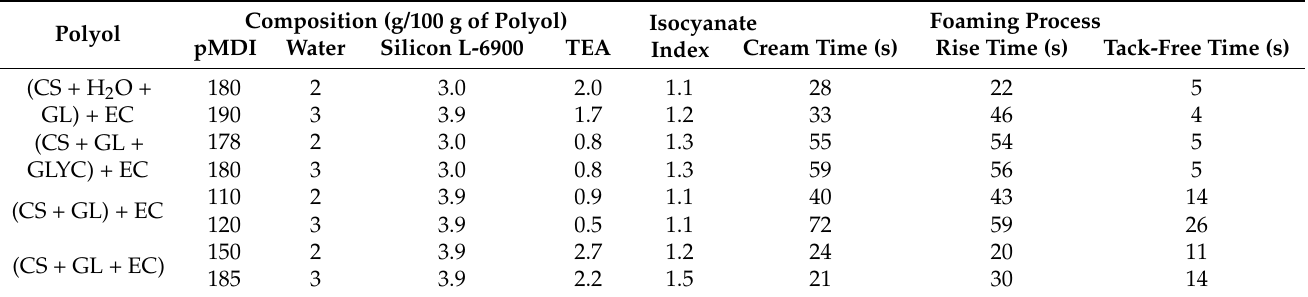
Table 5. The influence of composition on the foaming process.